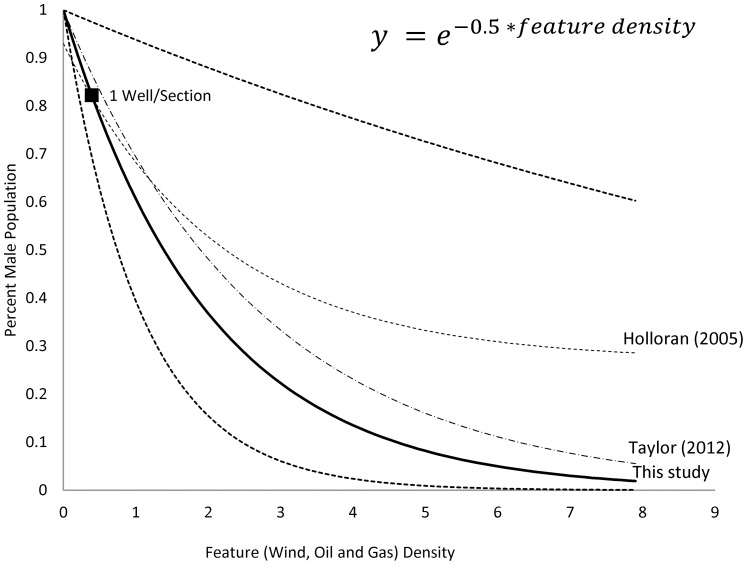
Sage-grouse population response to feature density regression relationship (solid line) with 95% CI (dotted lines).The feature density at one well per section is shown for reference, as well as the regression relationships for two similar studies.